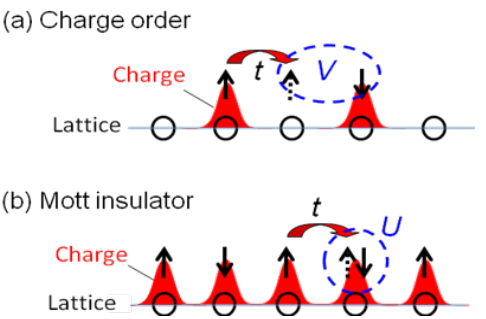
Figure 1. Schematic illustrations of ( a ) CO insulator and ( b ) Mott insulator. U , V , and t respectively represent on-site and inter-site Coulomb energies and an intermolecular transfer integral.